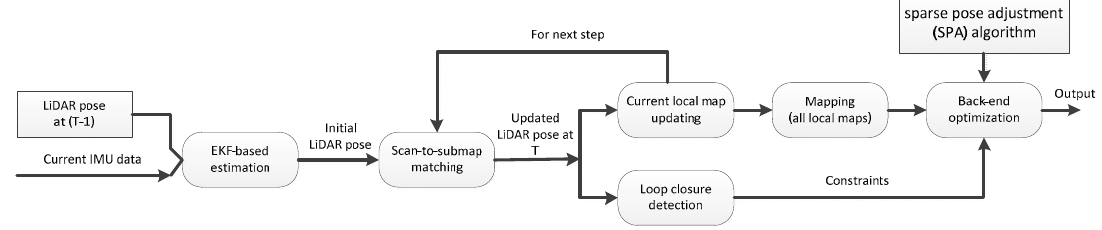
Figure 1. The data flow diagram of the proposed method.